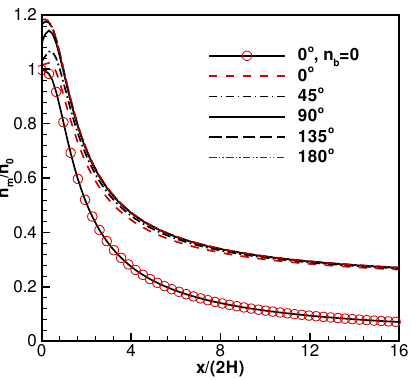
Figure 8. Background flow effects on centerline number density profiles for the mixture, n b / n 0 = 0.2, S 0 = 2.0, S b = 1.0, T 0 = 200 Kelvin, and T b = 300 Kelvin.